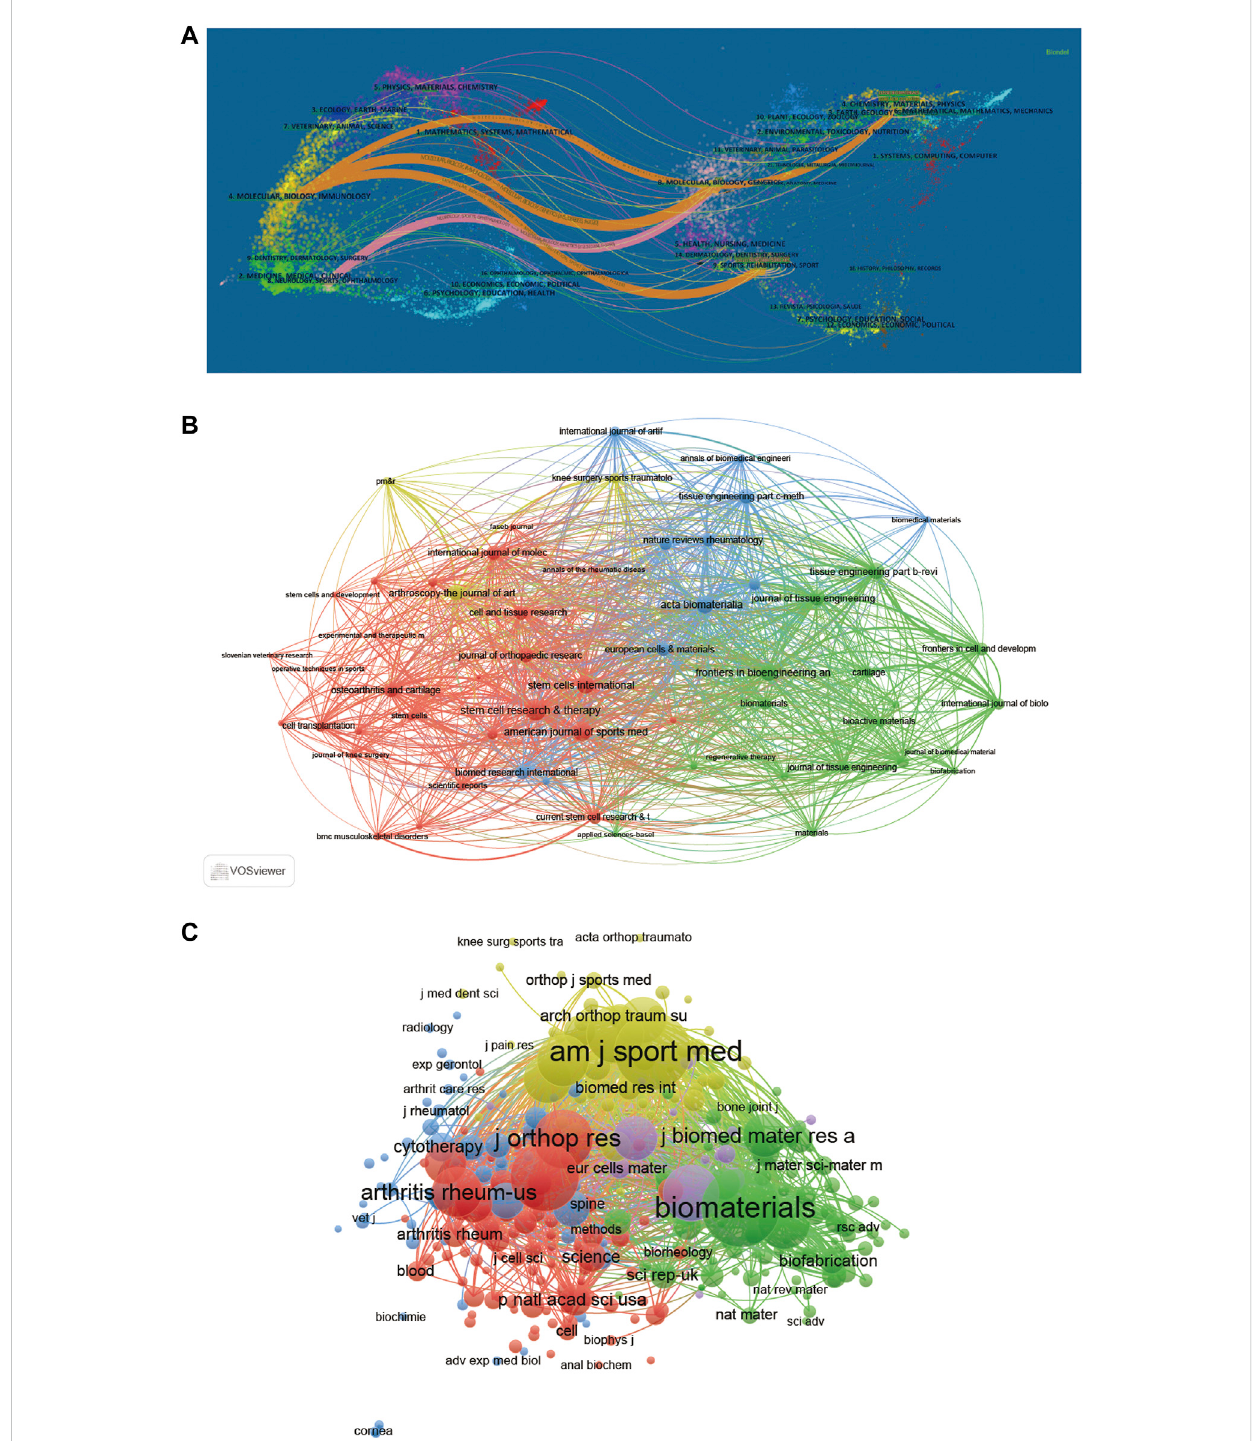
FIGURE 8 Articlespublishedindifferentjournalsonstemcellsformeniscalregeneration. (A) Thedual-mapoverlayofjournalsrelatedtostemcellsformeniscal regeneration. (B) BibliographicanalysisofjournalsbasedonVosviewer. (C) Networkmapofjournalsthatwerecocitedinmorethan50citationsbasedon